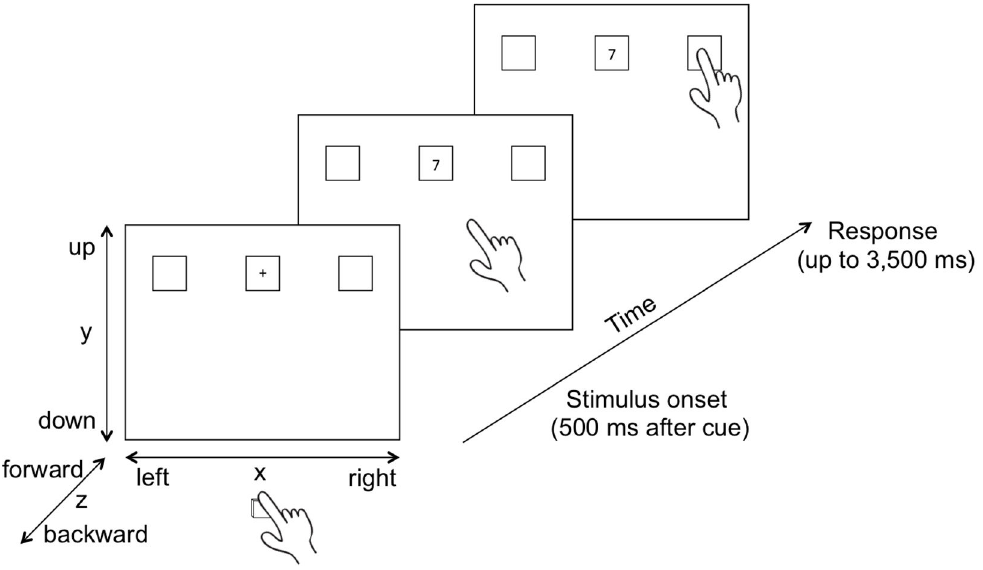
Figure 1. Illustration of the numerical comparison task. A digit (1-9) appeared in the center rectangle after a cue. Participants were instructed to touch the left rectangle for numbers 1-4, the center rectangle for 5, and the right rectangle for 6-9. Reach movements were recorded along the x (left-right), y (up-down), and z (forward-backward) axes. Figure adapted from Song and Nakayama